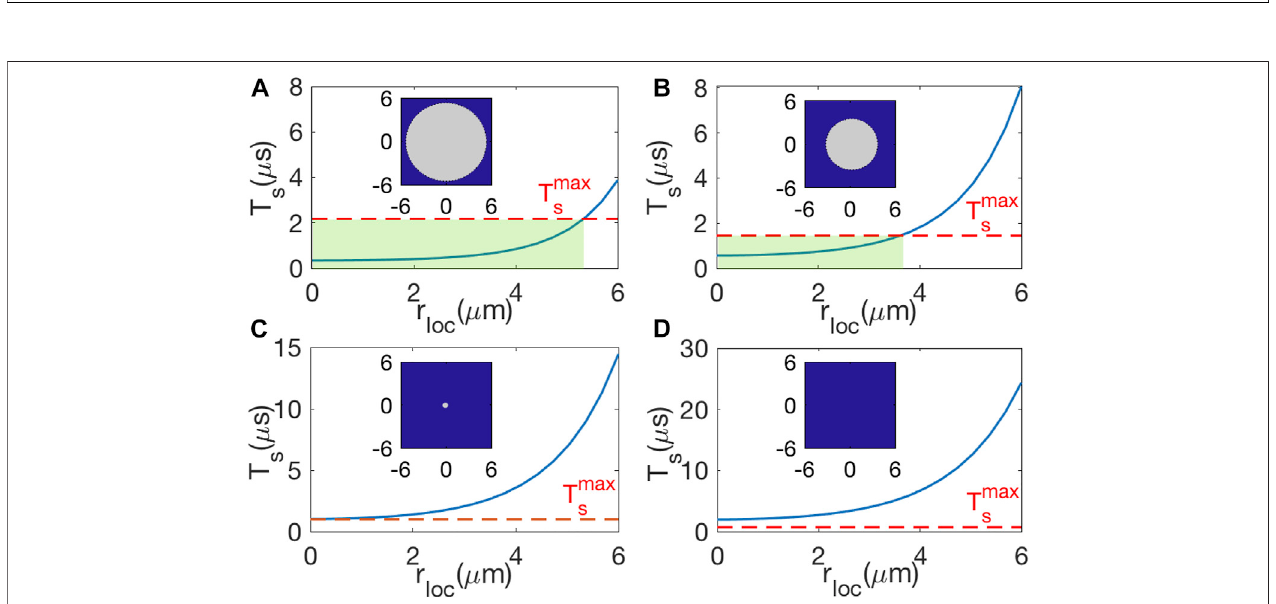
FIGURE5| Steadytime T s vs.theradiusdistance r loc under (A) Ω p 0 /2 π =4.5 MHzand a r =300 nm, (B) Ω p 0 /2 π =3.0 MHzand a r =200 nm, (C) Ω p 0 /2 π =2.1 MHz and a r = 141 nm, and (D) Ω p 0 /2 π = 1.5 MHz and a r = 100 nm. The red-dashed line denotes the maximal T s permitted for an ef fi cient localization. The shaded-green regionstandsfortheradialrangewhereatomscanbelocalized.Insets:effectiveoff-axislocalizationisenabledwithinthegraydisk.Here, Ω c10 /2 π =150 MHz, W =5 μ m , Ω Ω μ K , and Γ c20 = r loc c10 / W , T = 1 21 = 5